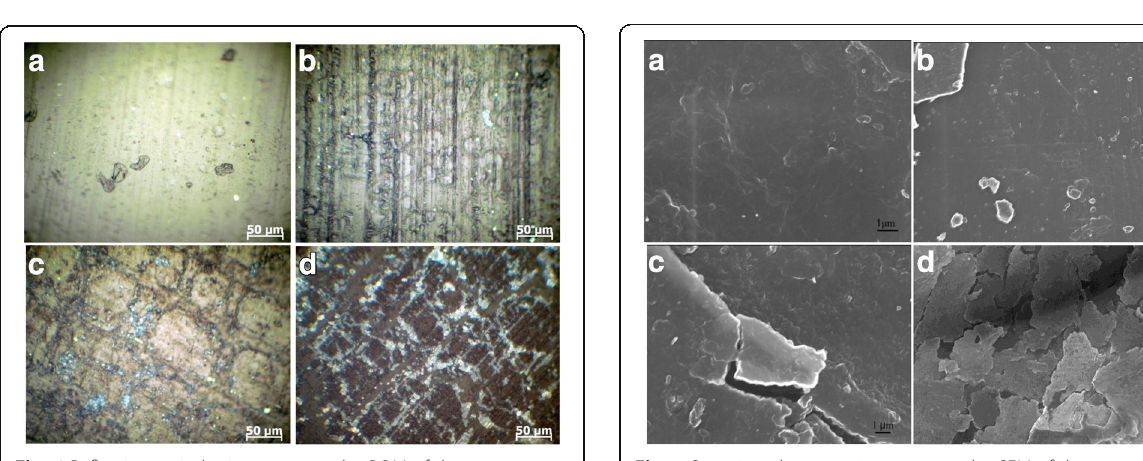
Fig. 7 Scanning electron microscopy results. SEM of the composites with a 0, b 10, c 20, and d 50 phr LiClO 4